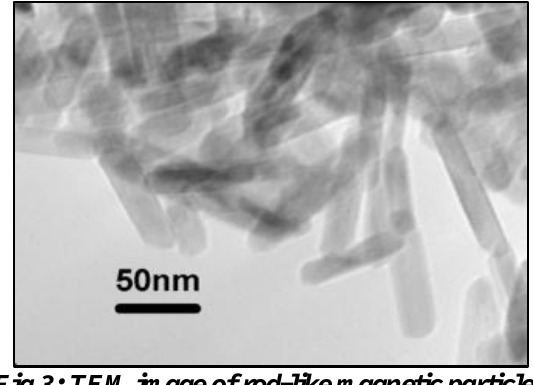
Fig.3: TEM image of rod-like magnetic